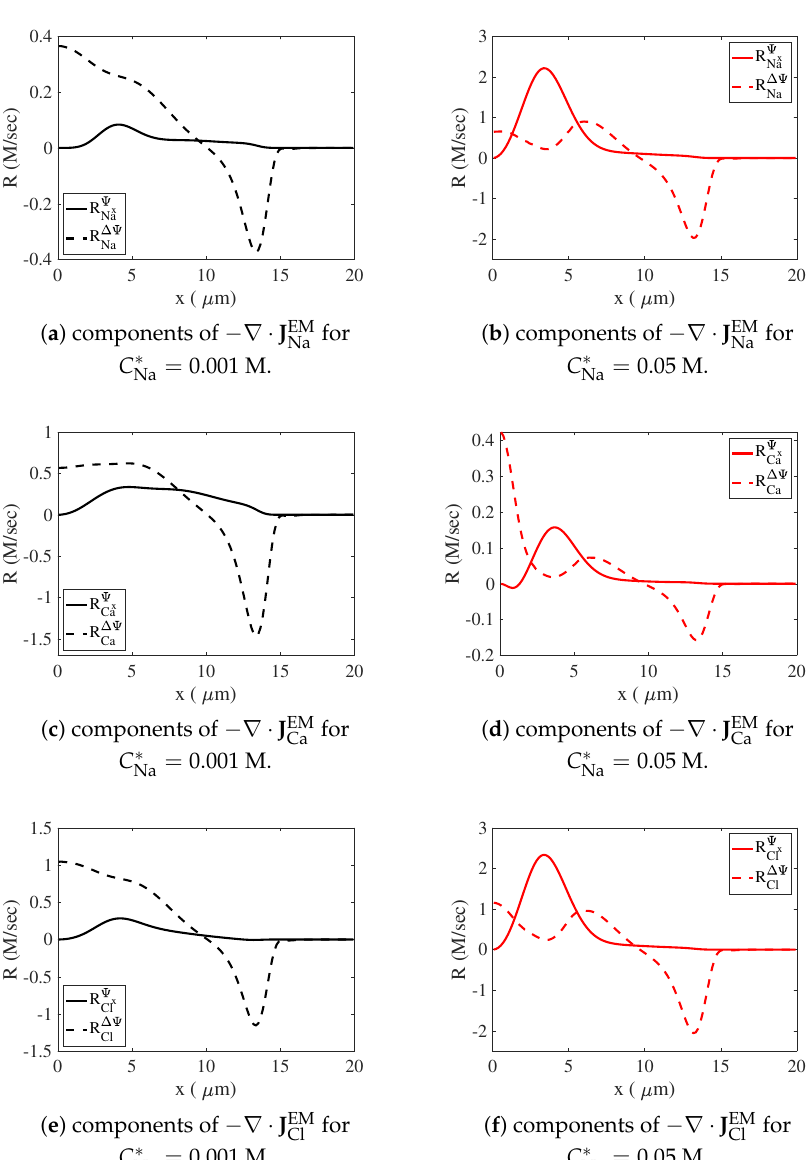
Figure 9. Rates of charge accumulation due to electromigration of various ions at t = 0.32 ms. All solid curves represent the contribution from terms containing Ψ x . All dashed curves represent the contribution from terms containing ∆Ψ